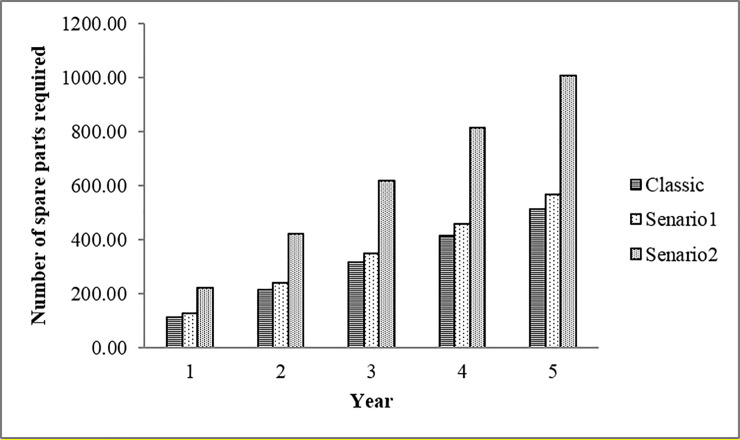
The number of EBN.